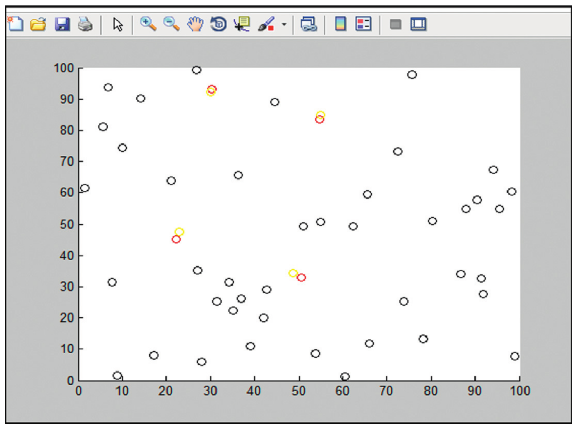
Figure 4: Structure of the proposed clustering